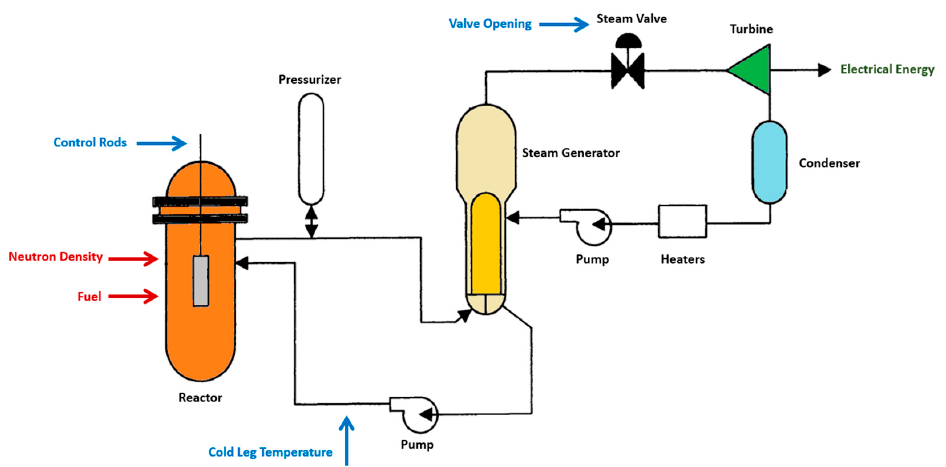
Figure 5. Modeling schematic.